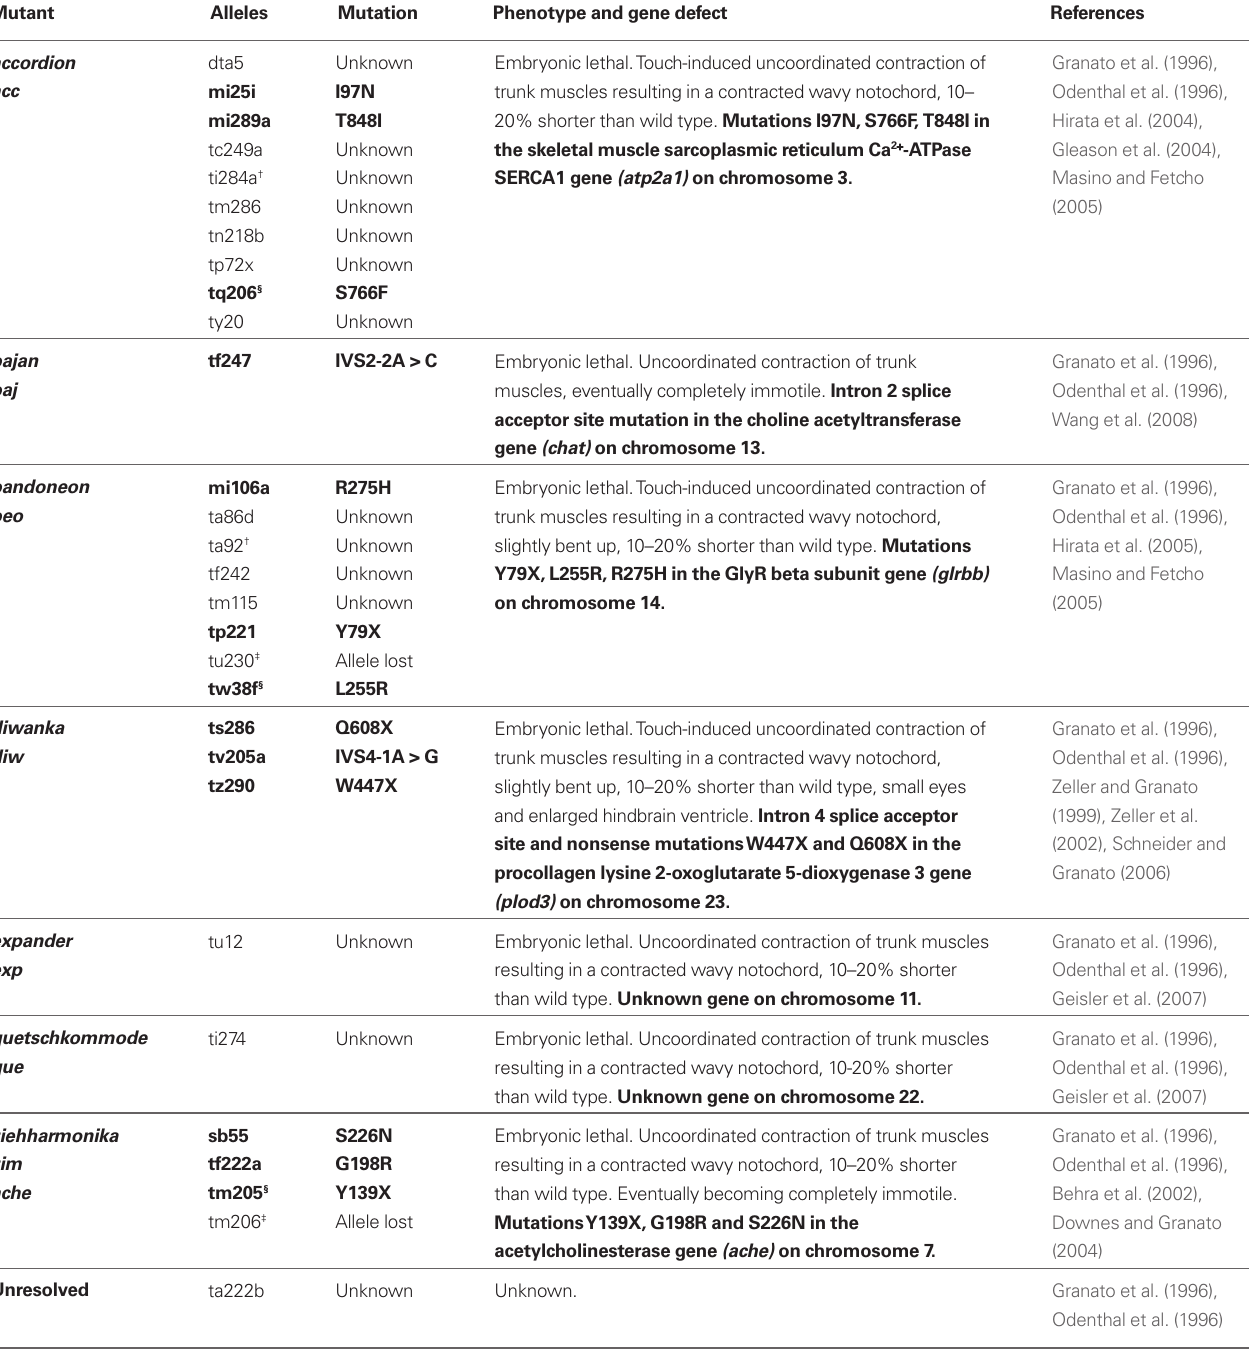
Table 1 | Accordion mutants. Mutant Alleles Mutation Phenotype and gene defect